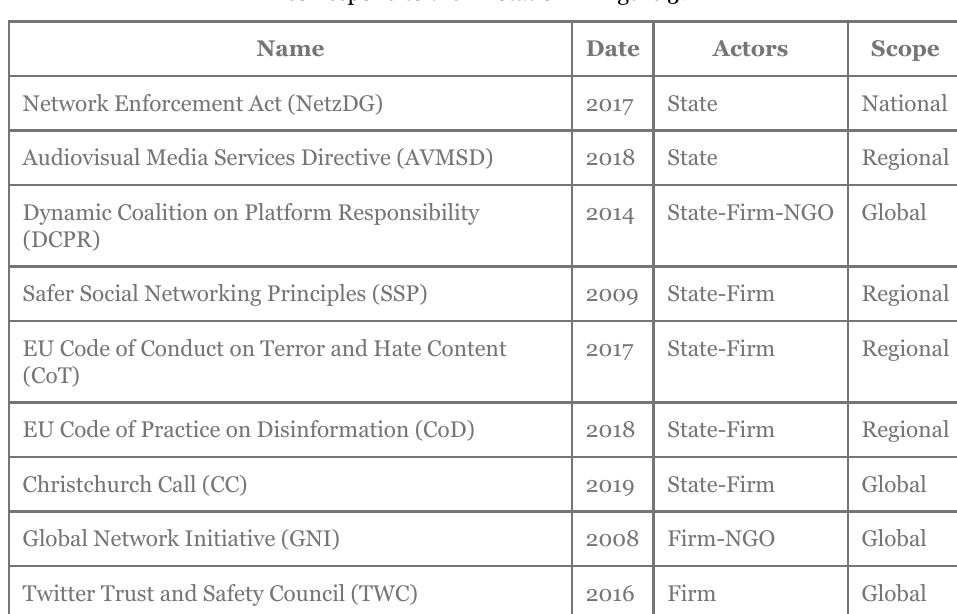
Figure 3: ‘Platform Governance Triangle’ depicting the EU content regulation landscape, author's own formulation. Table 1: Content governance landscape for platforms operating in the EU. Abbreviations correspond to their notation in Figure